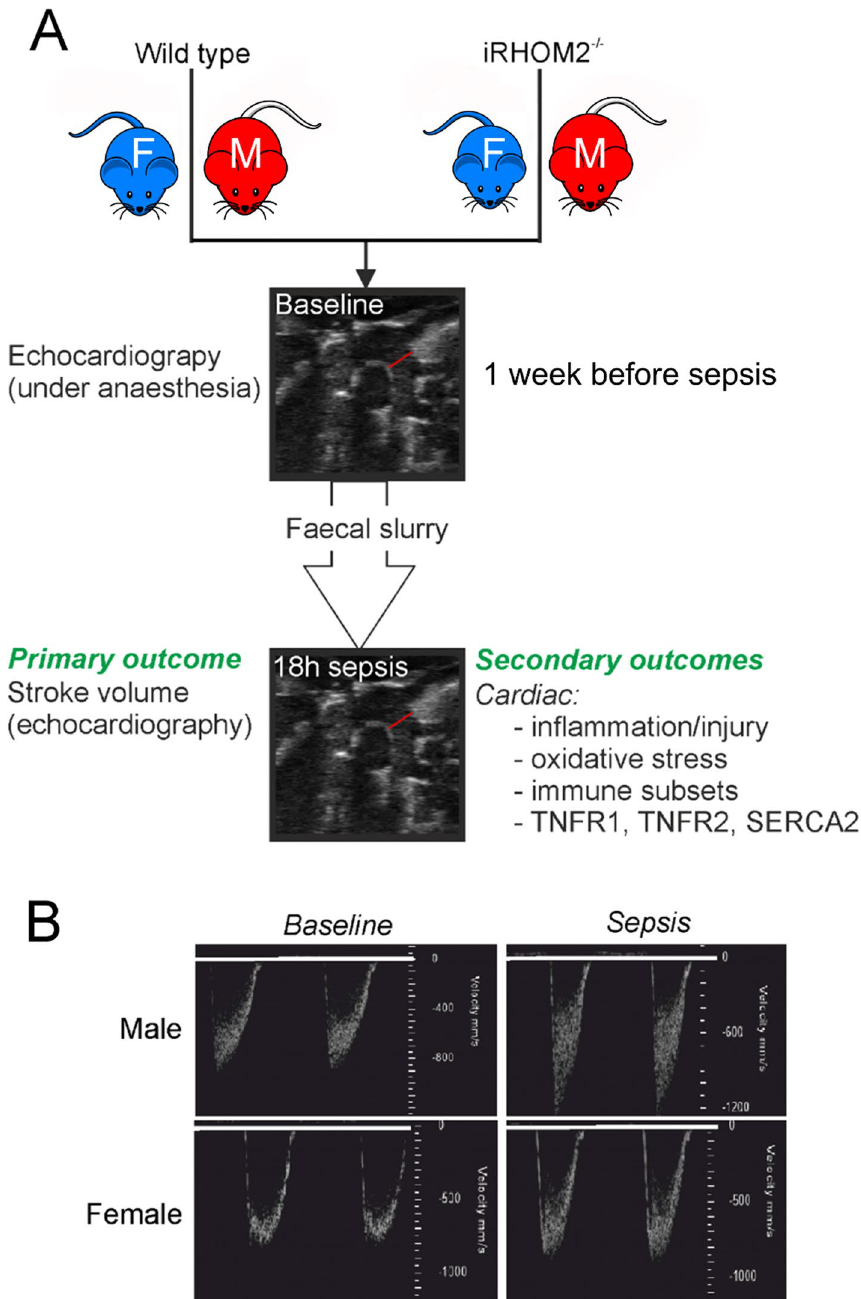
Fig. 1 Experimental protocol. A Summary of protocol, including primary and secondary outcomes. Colours for female/male mice for each genotype are used throughout the results section for clarity. B Typical echocardiography results in one female and one male mouse, before and 18 h after onset of sepsis showing pulmonary velocity time interval echocardiographic